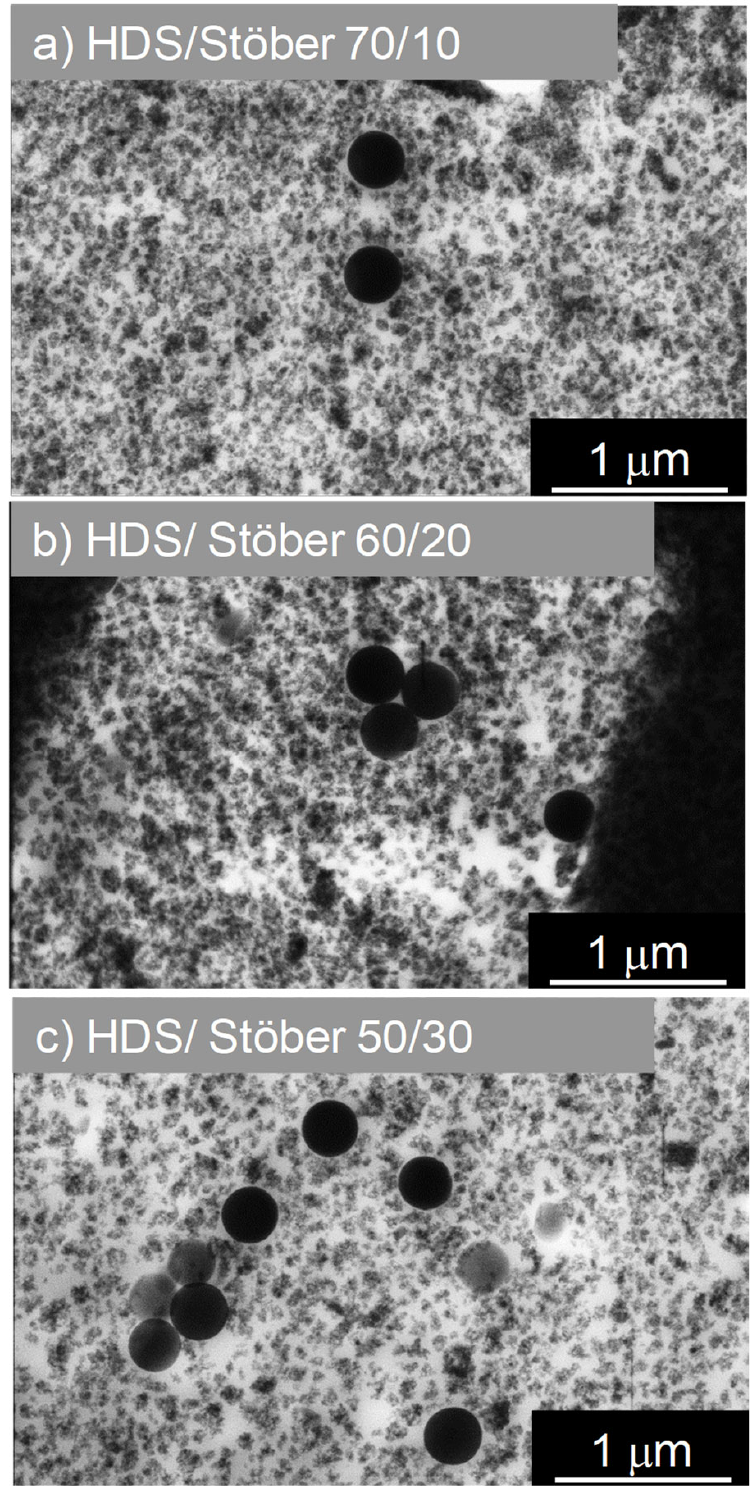
Figure 3. STEM images of nanocomposites synthesized with dual filler: ( a ) HDS/Stöber-70/10, ( b ) HDS/Stöber-60/20, ( c ) HDS/Stöber-50/30. The total silica filler charge in all nanocomposites was kept constant at 80 phr. We can clearly distinguish on STEM pictures reported in Figure 1 the spatial distribution of silica fillers in composites. In the case of nanocomposites prepared with Sepiolite nanorods (Figure 1a), HDS nanoparticles (Figure 1b), or Stöber nanoparticles (Figure 1c) as